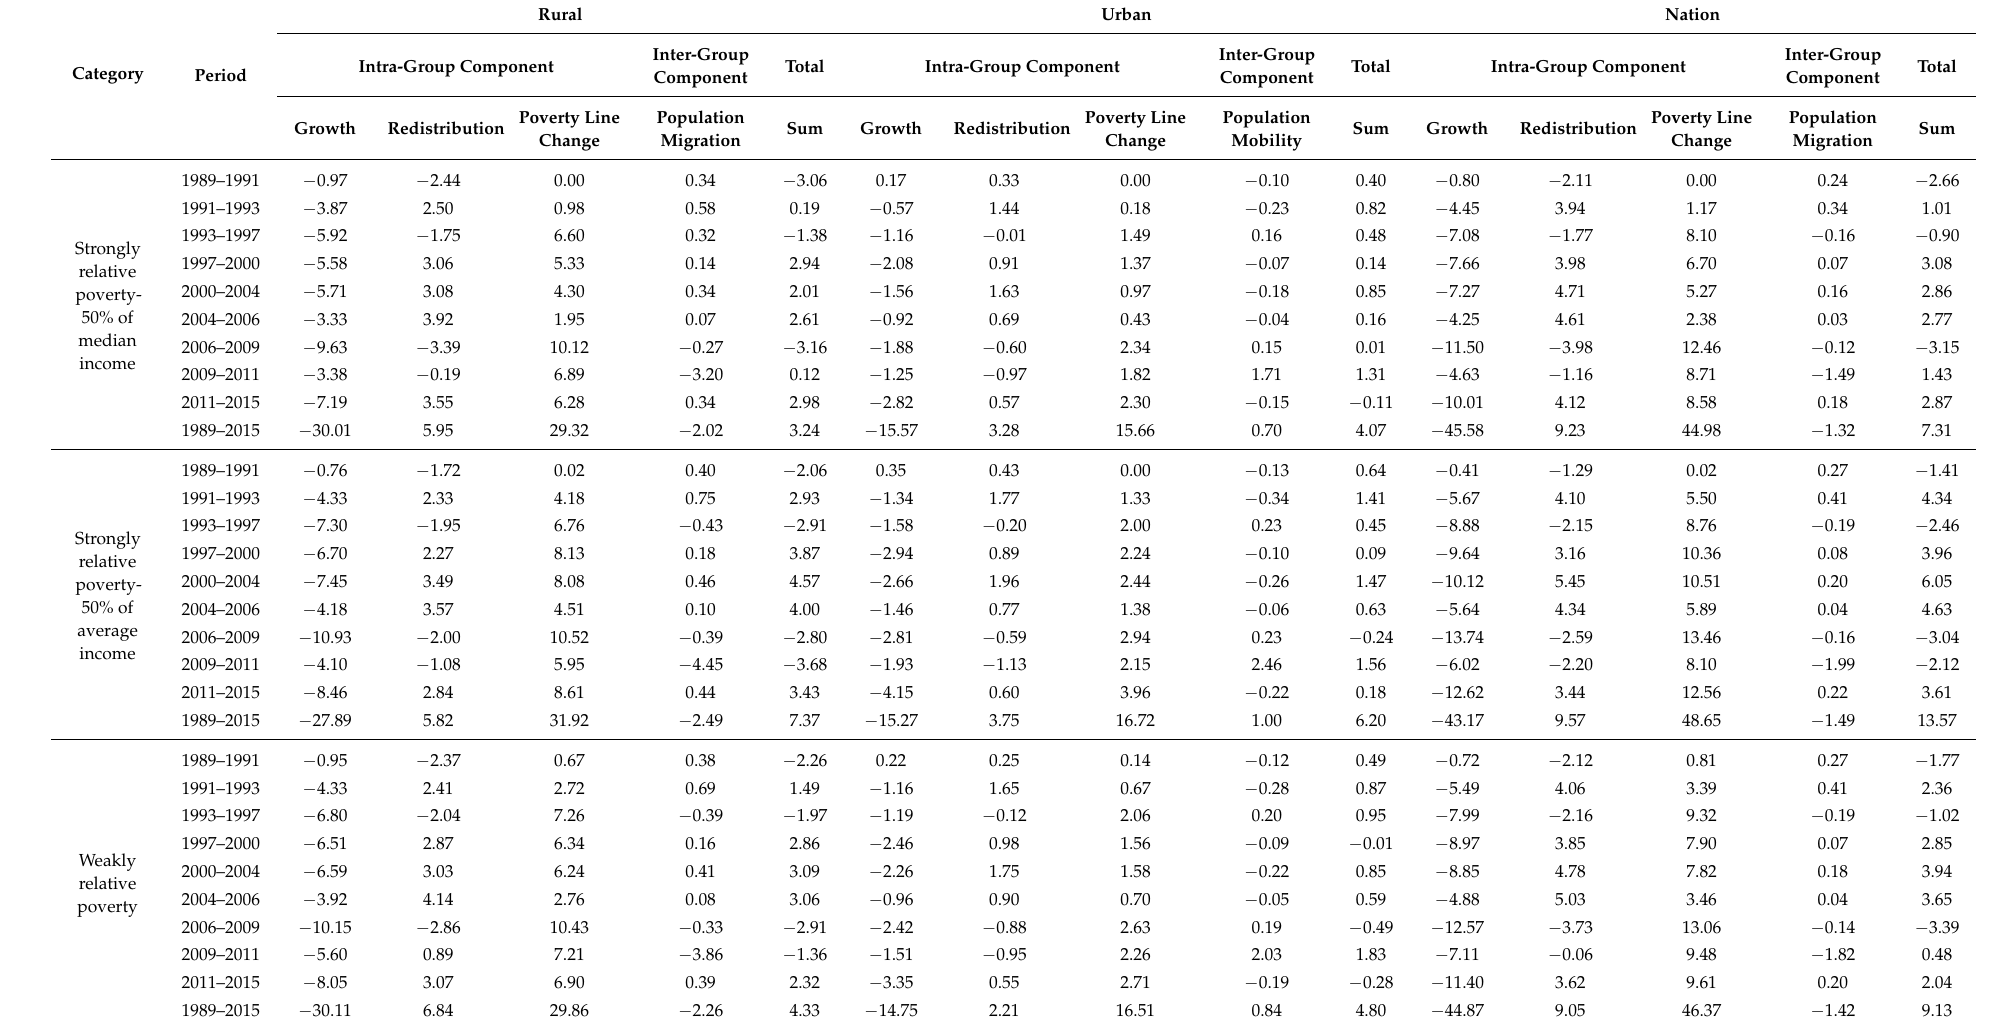
Table 8. Intra-group and inter-group decomposition of relative poverty change